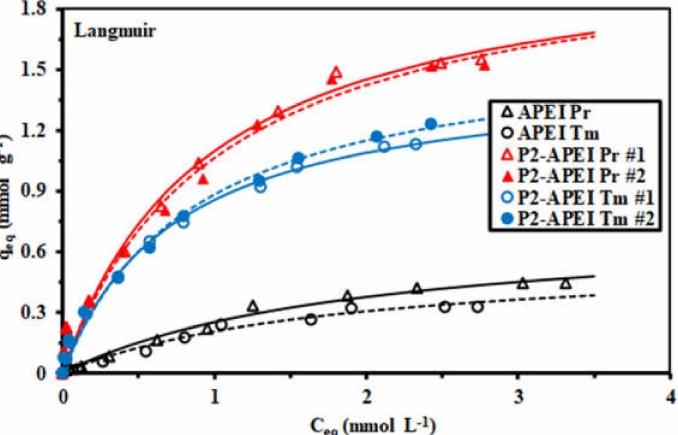
Figure 7. Pr(III) and Tm(III) sorption isotherms using APEI and P2-APEI (duplicate experiments) (C 0 : 10–500 mg L − 1 ; Sorbent dosage, SD: 0.5 g L − 1 ; pH 0 : 5; pH eq : 4.81–4.7 and 4.79–4.72 for APEI for Pr(III) and Tm(III), respectively; 3.27–3.08 for Pr(III) and 3.54–3.39 for Tm(III) with P2-APEI; time: 48 h; T: 22 ± 1 ◦ C; solid lines: modeling with the Langmuir